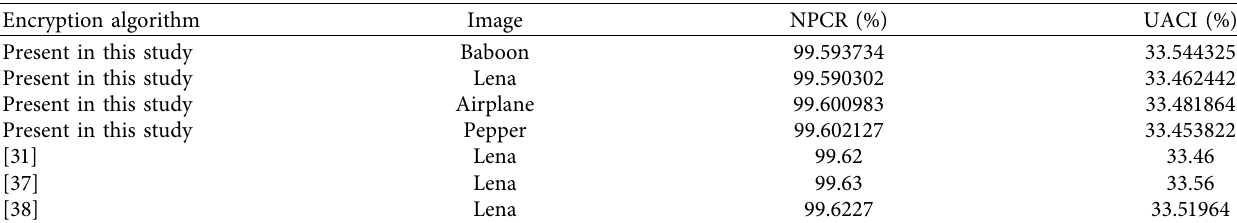
Table 4: NPCR and UACI of cipher